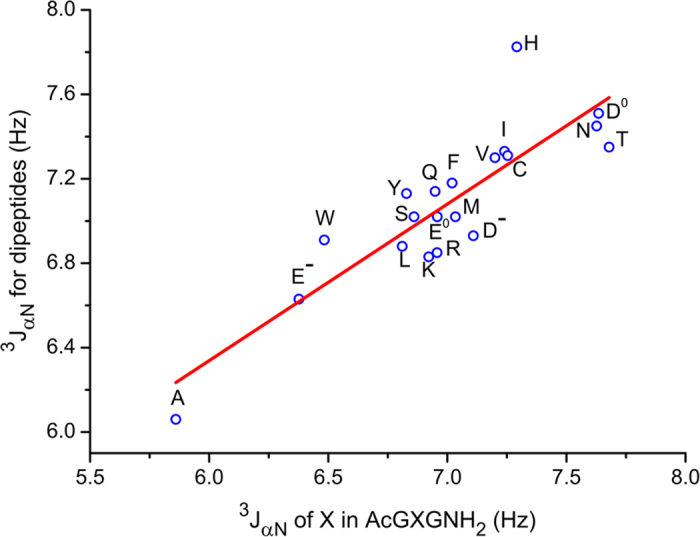
The 3JαN coupling constants measured for AcGXGNH2 peptides are plotted against those for amino acid dipeptides.